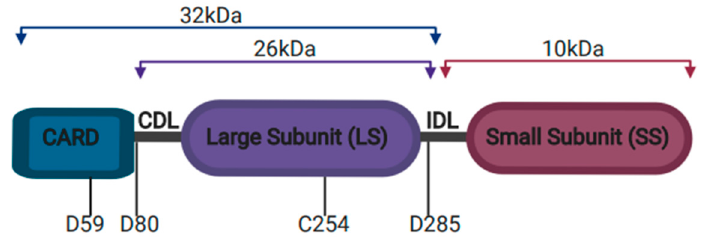
Figure 1. Caspase-11 structural domains. Caspase-11 is comprised of three domains; the N-terminal CARD domain is separated from the large subunit (26 kDa) by a CARD domain linker region (CDL). The large subunit and C-terminal small subunit (10 kDa) are the catalytic domains, separated by the inter-domain linker region (IDL). Caspase-11 auto-proteolysis involves CDL cleavage at D59 and D80 to remove the CARD domain. The large and small catalytic domains are separated by processing of IDL at D285, to generate subunits P10 and P26 or P32. The active cysteine residue C254 is located within the enzymatic active site of the large subunit.